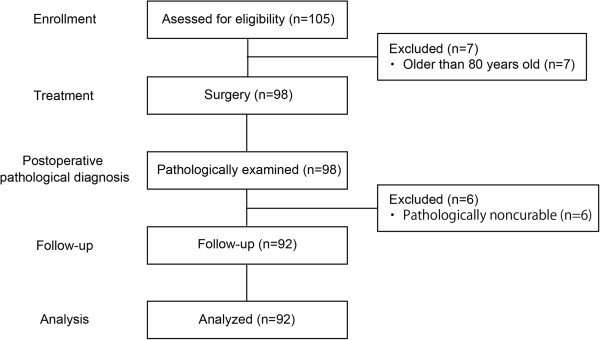
Flow diagram of the patients in this study. Total 92 patients who underwent curative surgical resection for esophagogastric junctional cancer at the Digestive Disease Center, Showa University Northern Yokohama Hospital between October 2001 and December 2010 were retrospectively studied.